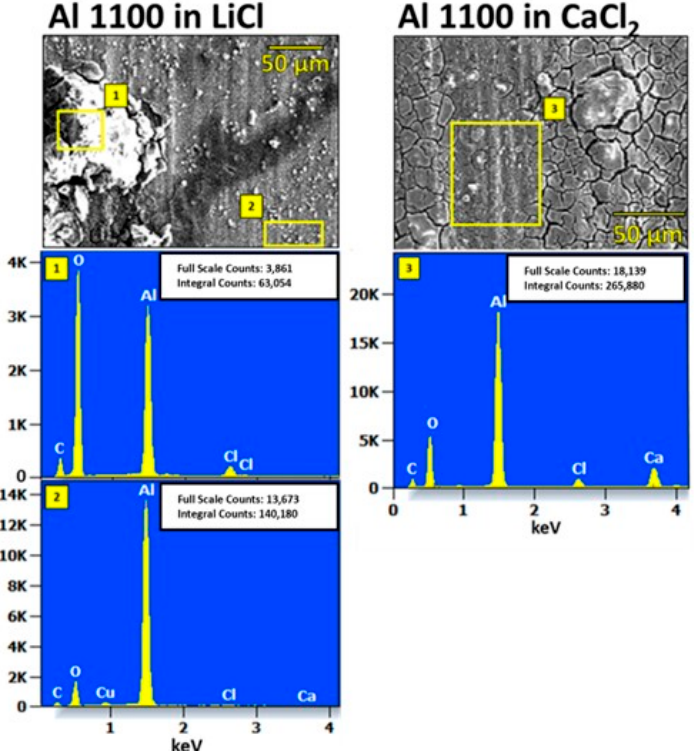
Figure 10. FESEM-EDX surface analysis of Al 3003 samples after electrochemical corrosion experiment in 30 wt. % LiCl solution and 40 wt. % CaCl 2 solution at 80 °C. The composition of the surface varied.